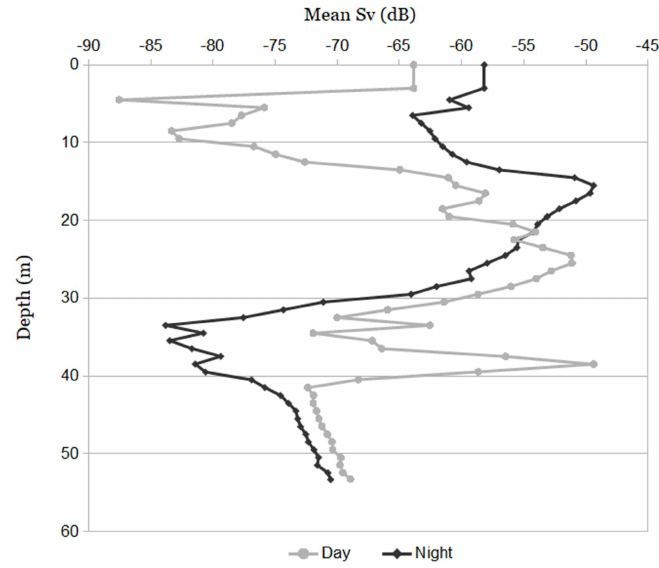
Figure 2. S V (dB) vertical distribution during the day and night survey in Lake Trichonis.